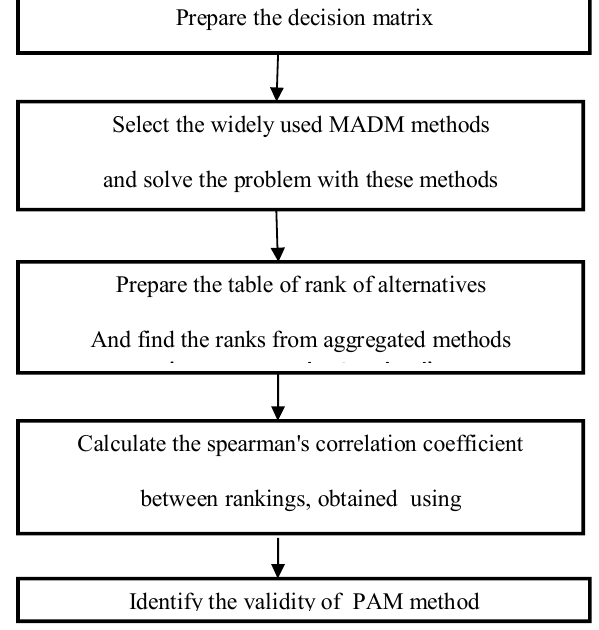
Fig. 1. Framework of decision